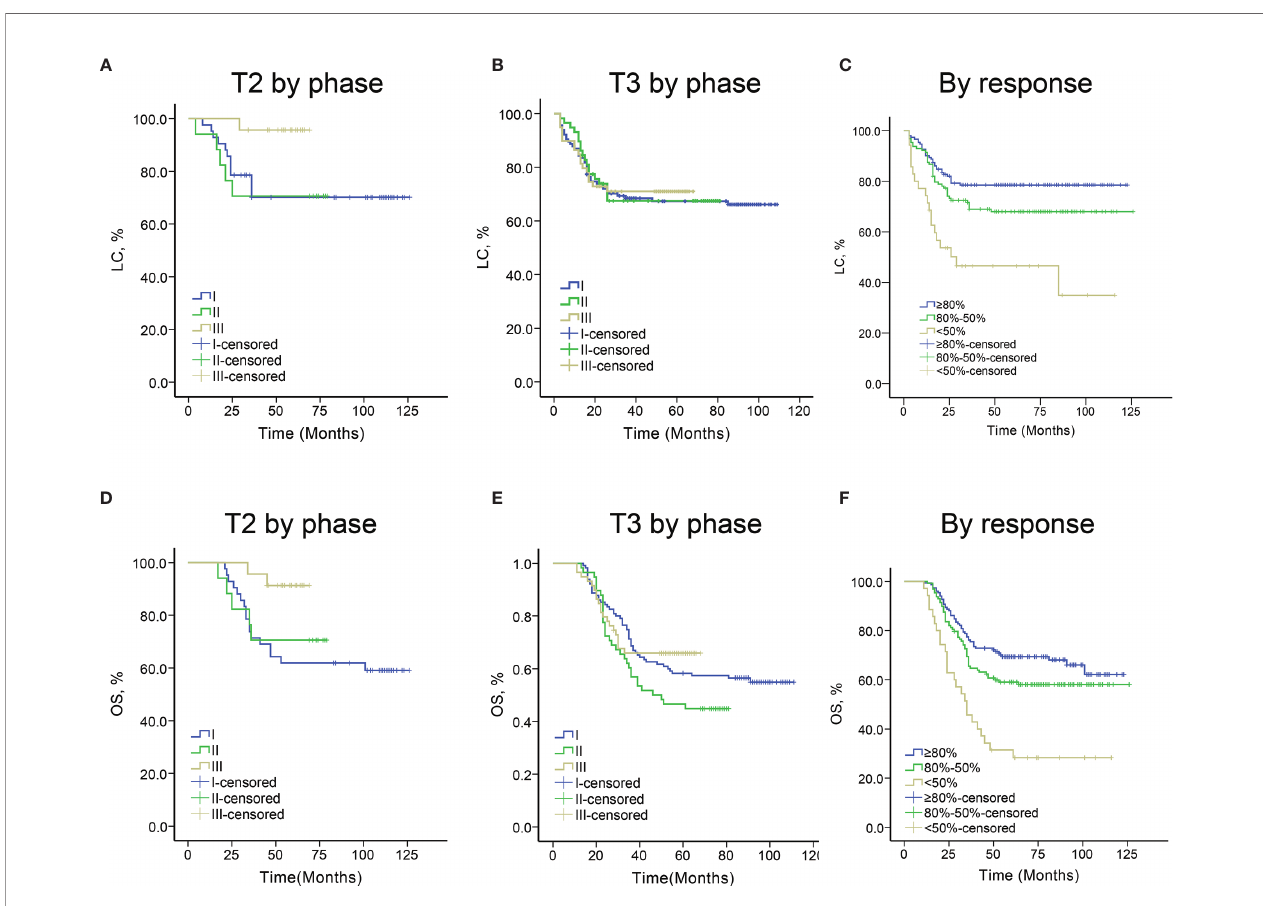
FIGURE 3 | (A) Local control curves by different initial response groups. (B) Overall survival curves by different initial response groups. (C) Local control curves in patients with T2 tumors by different phases of the current study. (D) Overall survival curves in patients with T2 tumors by different phases of the current study. (E) Local control curves in patients with T3 tumors by different phases of the current study. (F) Overall survival curves in patients with T3 tumors by different phases of the current